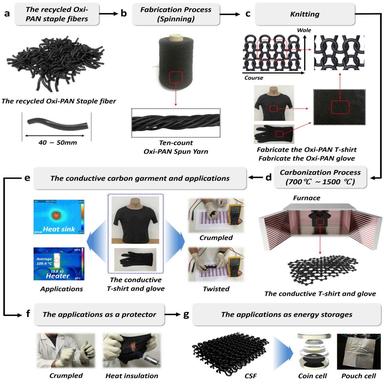
Schematic of the preparation and application of conductive knitted fabrics. a Oxi-PAN staple fibers. b Oxi-PAN spun fibers manufactured by the spinning process. c Preparation of the Oxi-PAN spun fabrics, T-shirt, and gloves by the knitting process. d Preparation of the CSF, T-shirt, and gloves by the carbonization process. e Fabrication of the conductive T-shirt and gloves and their application as heat sinks and heaters using the CSF. f Application to heat insulation using the CSF. g The CSF with 3D porous